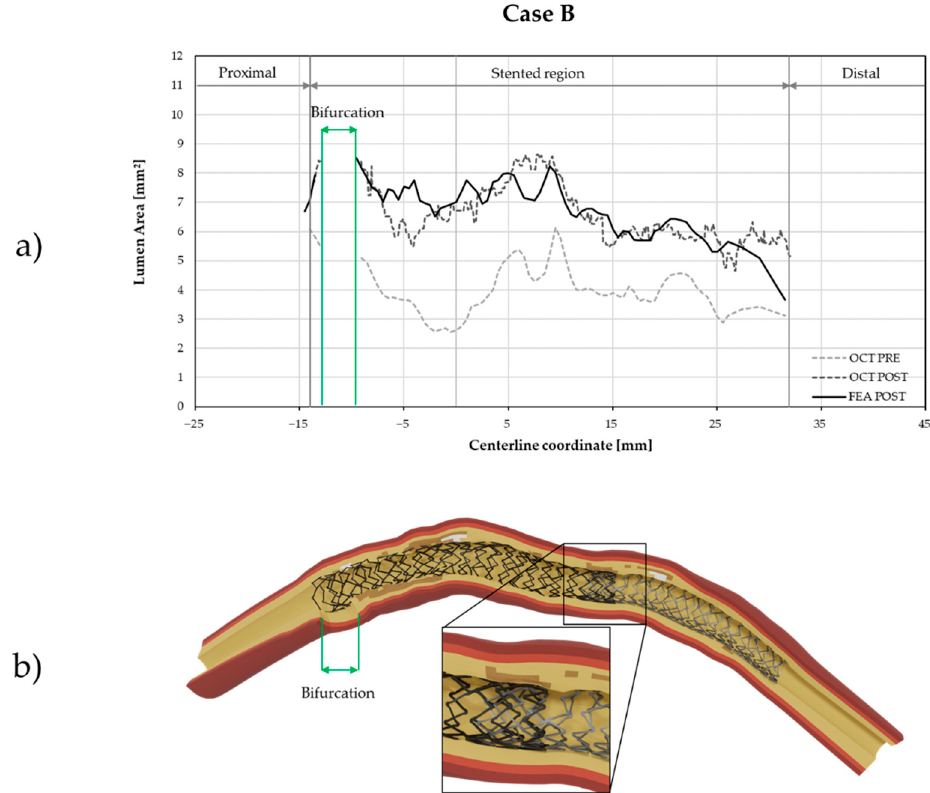
Figure 8. Numerical simulation results for the replication of Case B: ( a ) graph of the lumen area as a function of the centerline coordinate with the curves related to the clinical data deduced from pre- and post-treatment OCTs and the FEA results. The region corresponding to the bifurcation was not considered in the lumen area comparison; ( b ) the geometry of artery section and stent at the end of clinical treatment with detail on the region with overlapping stents.